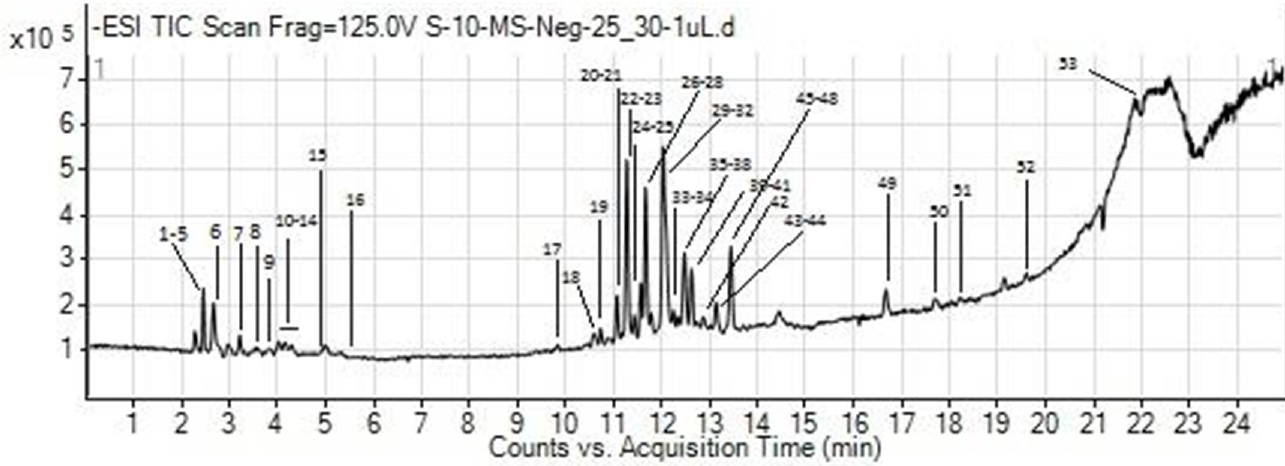
Figure 10. LC–MS chromatogram of DB–B. Table 1. List of compounds identified by LC-MS analysis of DB-B.